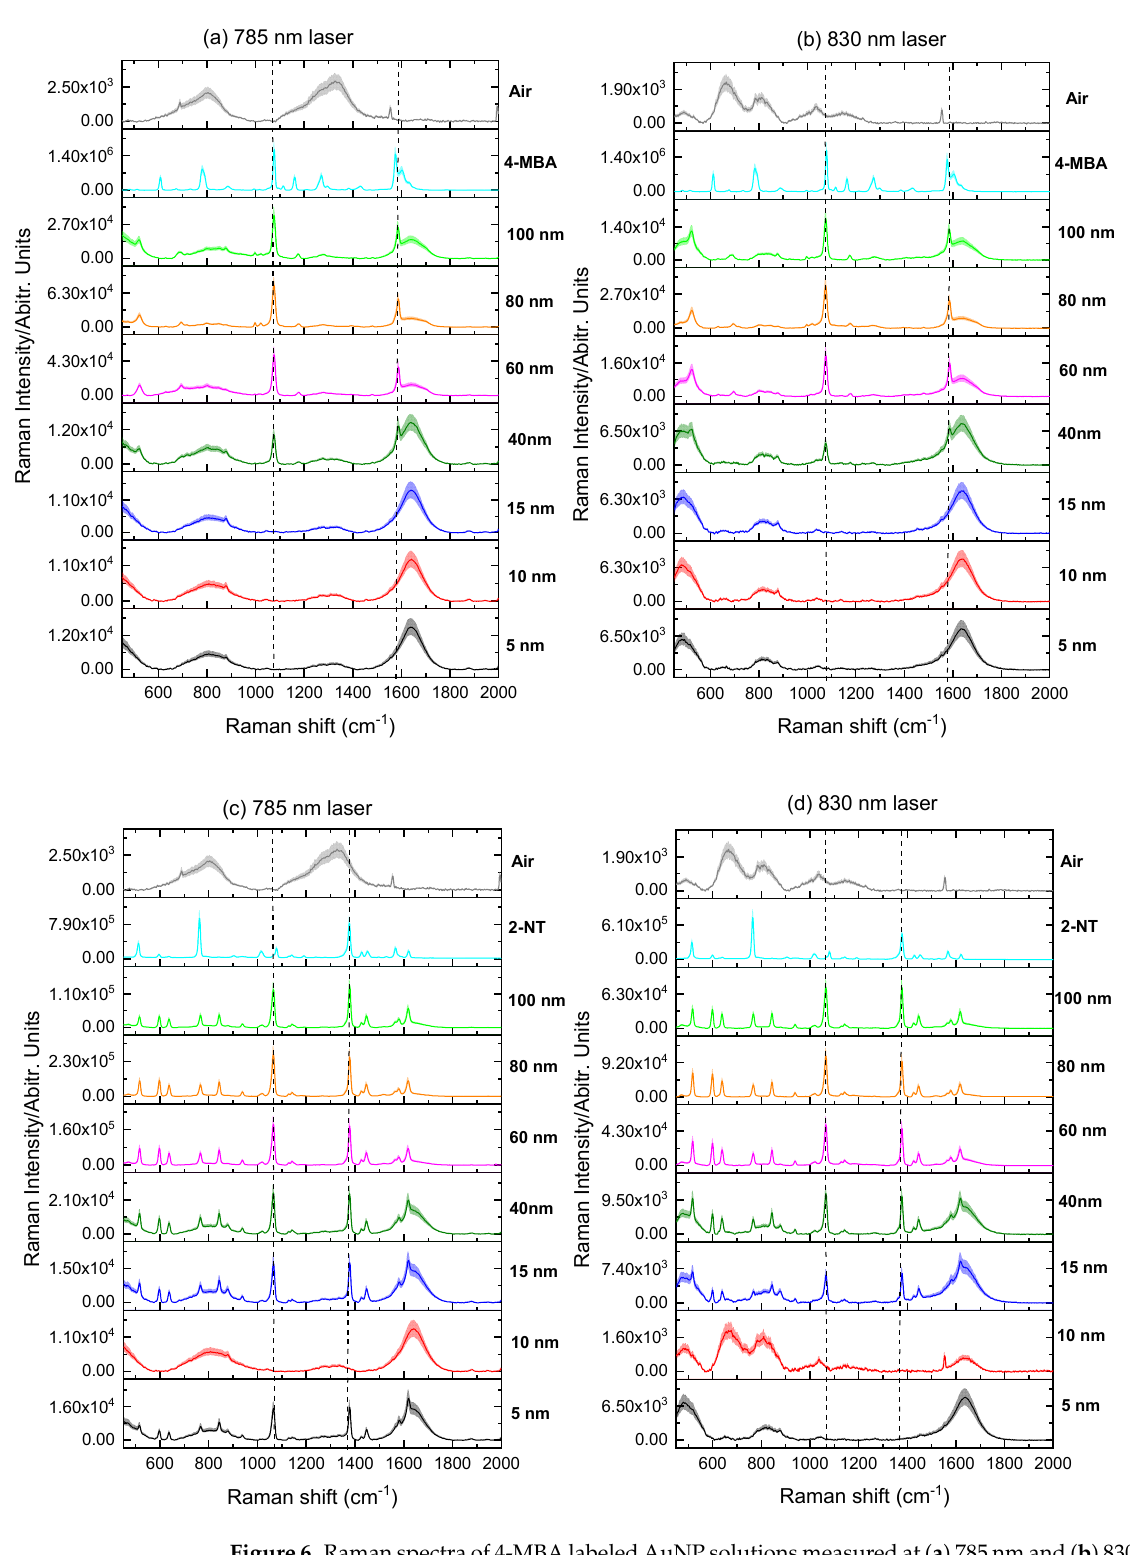
Figure 6. Raman spectra of 4-MBA labeled AuNP solutions measured at ( a ) 785 nm and ( b ) 830 nm; Raman spectra of 2-NT labeled AuNP solutions measured at ( c ) 785 nm and ( d ) 830 nm. Dashed lines denote the two most prominent signals of 4-MBA at 1078 and 1588 cm − 1 . Shading: standard deviation.